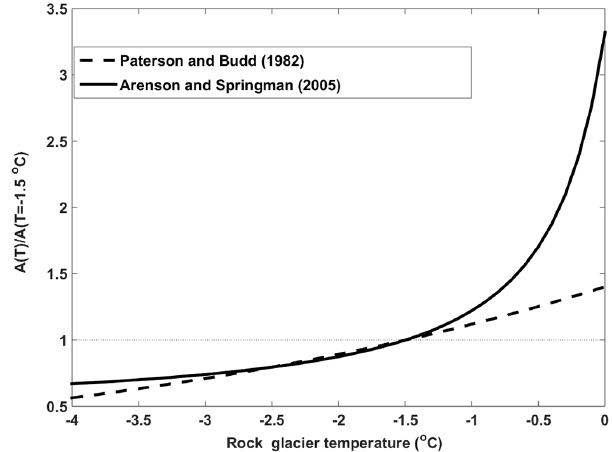
Figure 4. Temperature dependence of the rate factor relative to the rate factor at a reference temperature of − 1.5 ◦ C as derived for pure ice (Paterson and Budd, 1982) and for rock glacier material (Aren- son and Springman